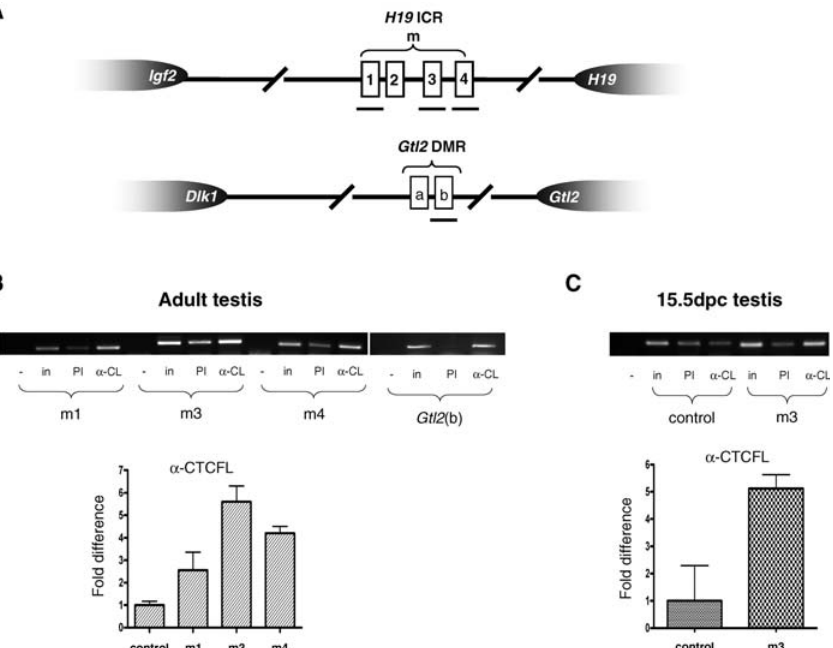
Figure 2. ChIP Analysis of CTCFL Association with the H19 ICR and Gtl2 DMR (A) Diagrams illustrate the regions within H19 ICR and Gtl2 DMR analyzed by ChIP. (B) Adult testis analysis. Upper panels show agarose gels of real-time PCR products for H19 ICR and standard PCR products for Gtl2 DMR. A no–DNA control ( (cid:1) )is indicated. Input (In) represents 10% of total amount of samples used. Pre-immune (PI) was used as a control for the enrichment of CTCFL immunoprecipitated with a -CTCFL ( a -CL) antibody. For Gtl2 DMR, normal rabbit serum (NRS) was used. Lower panel shows real-time PCR analysis of H19 ICR. Control represents genomic region lacking CTCF binding consensus sequence. (C) The 15.5-dpc testis analysis. Figure is organized as for (B). In this case, control is included in the upper